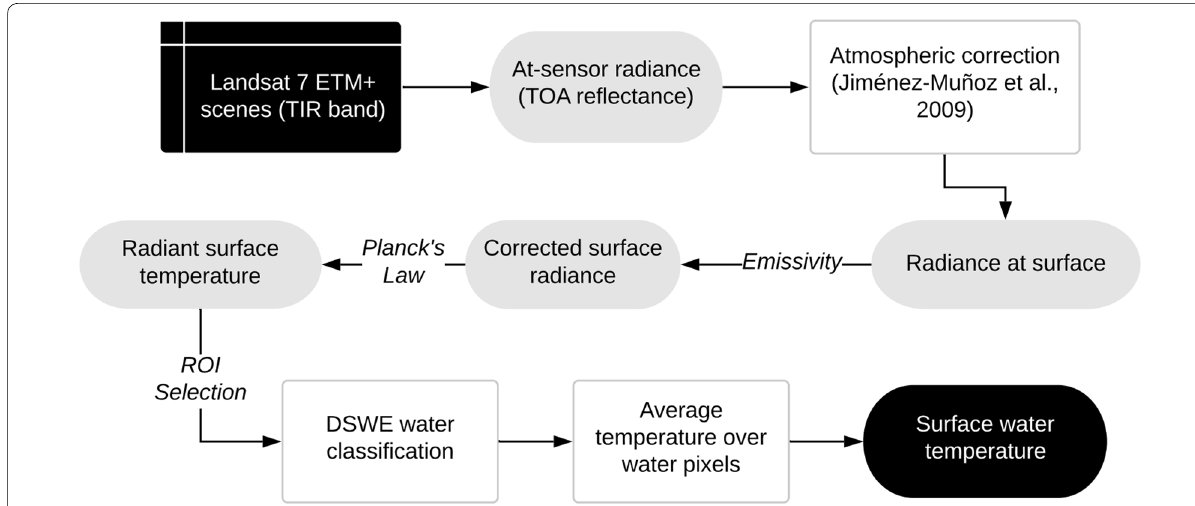
Fig. 6 Single channel (SC) algorithm using Landsat ETM